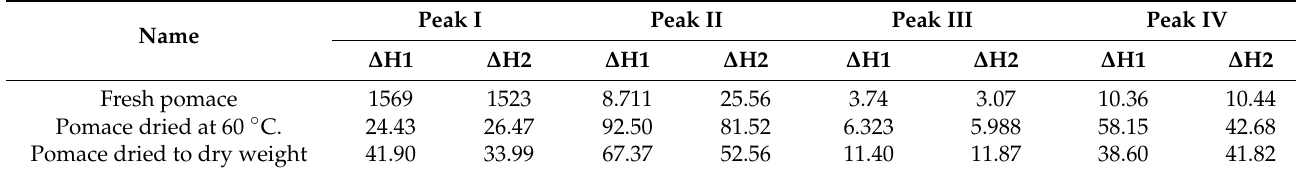
Table 4. Enthalpies of transformation (J/g) for apple-pomace samples based on the obtained DSC curves. Analysis under nitrogen